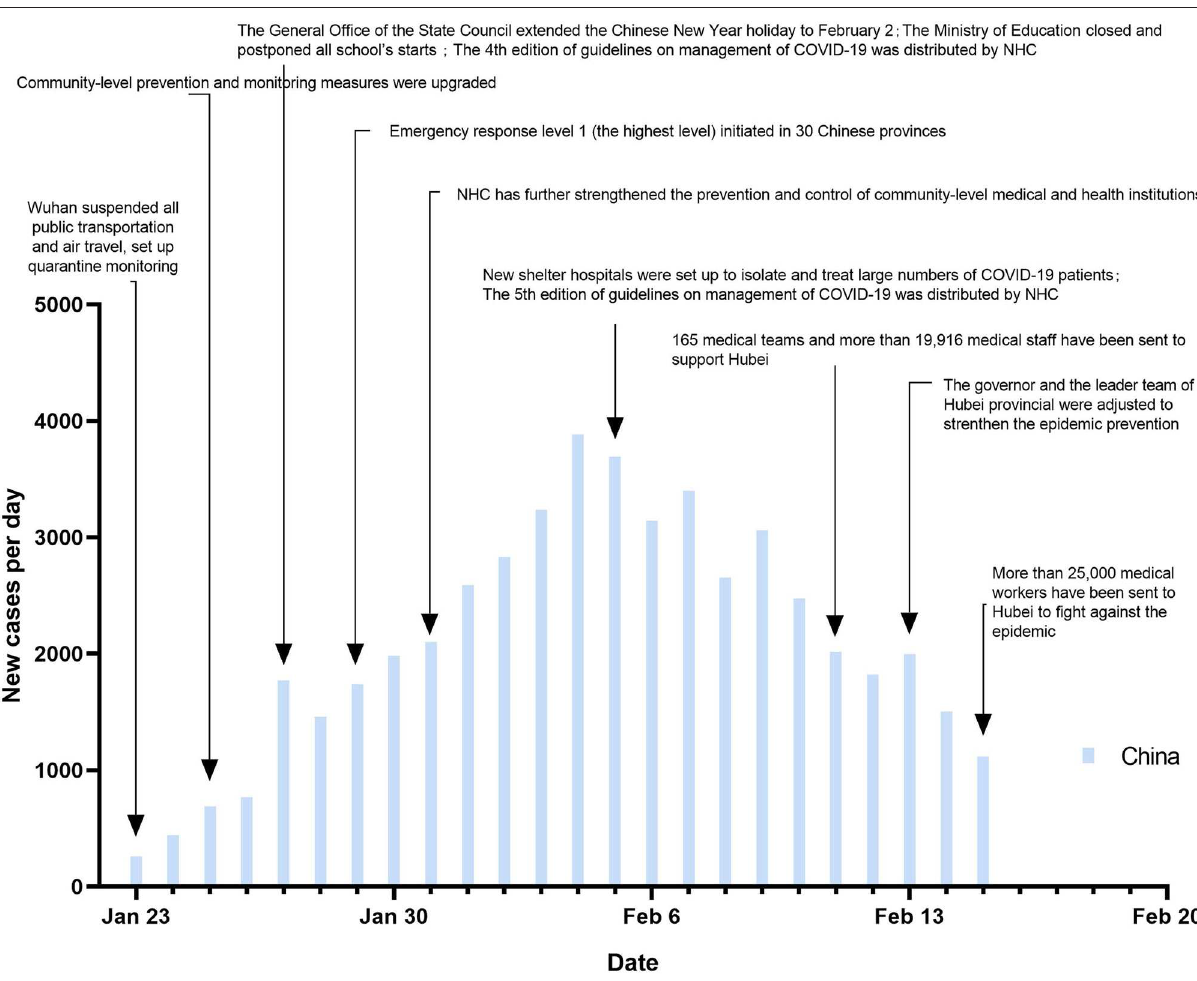
Frontiers in Medicine | www.frontiersin.org